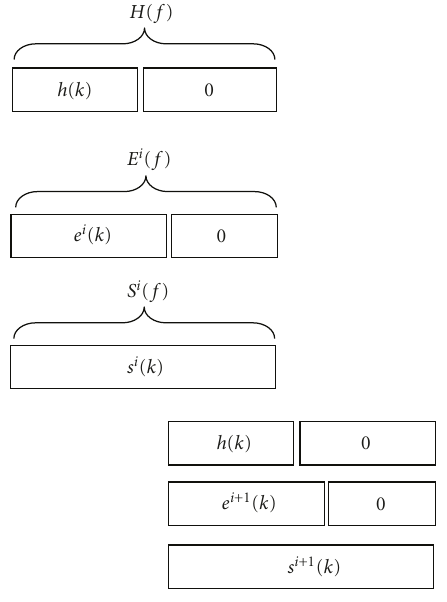
Figure 9: Overlapp-and-add